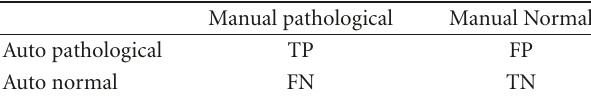
Table 1: Confusion matrix.